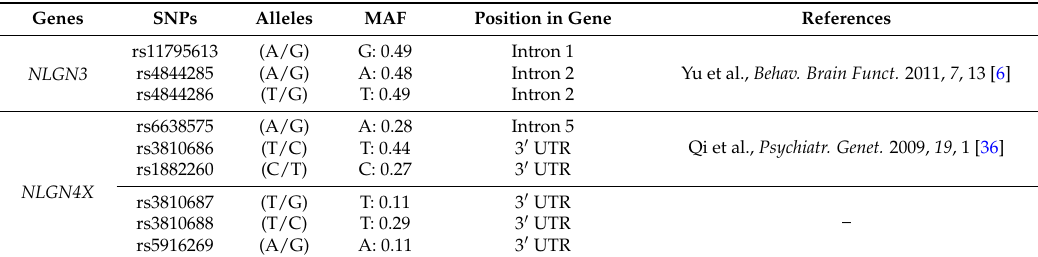
Table 6. List of SNPs analyzed in NLGN3 and NLGN4X